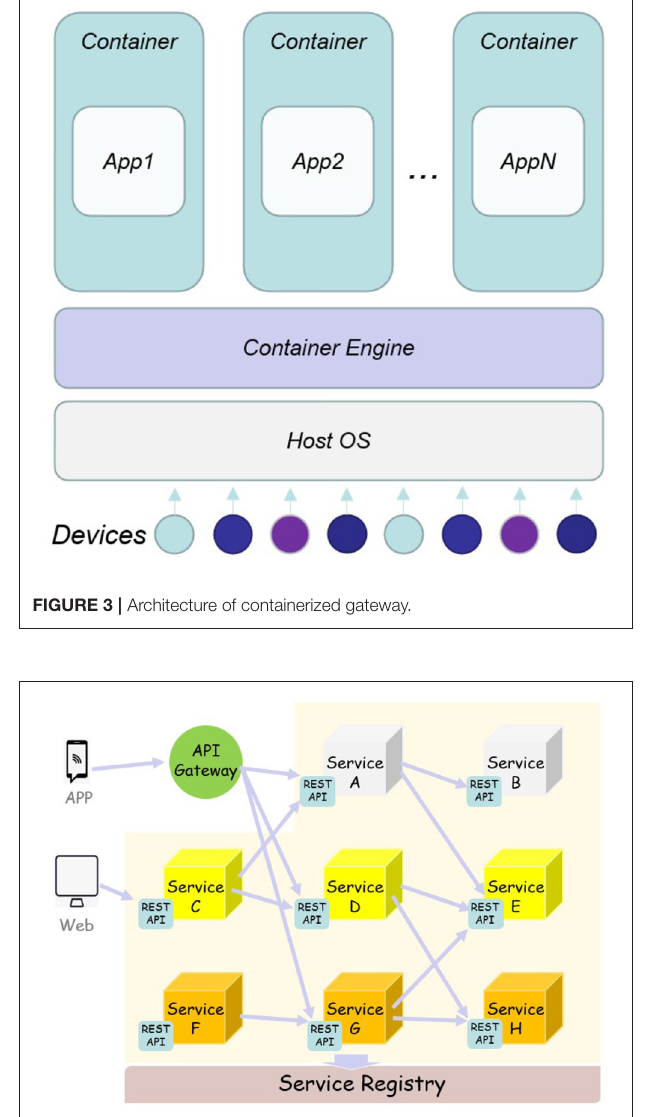
FIGURE 4 | Micro-service